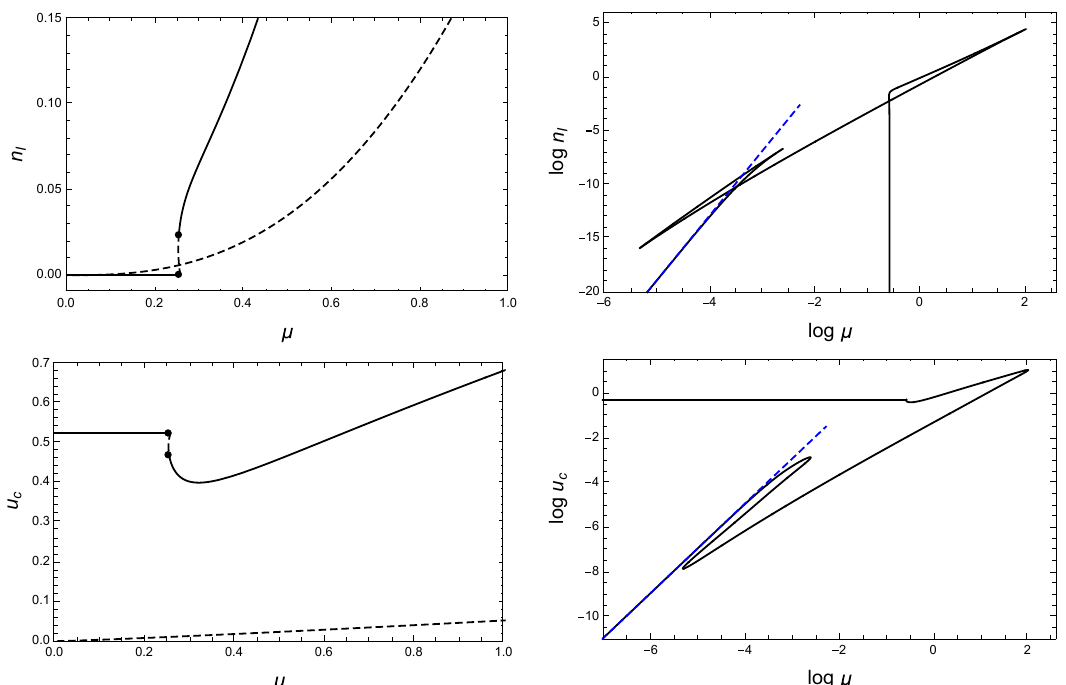
Figure 1 . Dimensionless baryon density n I (upper panels) and location of the tip of the connected (cid:13)avor branes u c (lower panels) as a function of the dimensionless chemical potential (cid:22) at zero temperature. In the left panels, solid lines are the stable branches, dashed lines are metastable or unstable. The right panels show the same quantities in double-logarithmic plots, now all branches shown as solid lines, together with the analytical result for small (cid:22) (blue dashed).